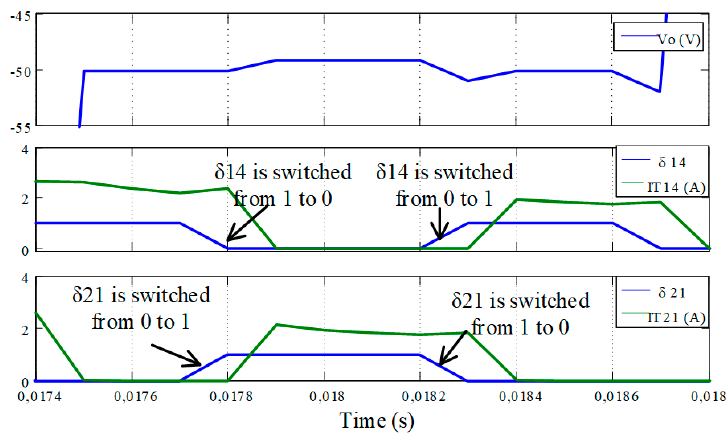
Figure 9. Output voltage V o (t), currents IT21 and IT14, and command of the switches T21 and T14 (Zoom 4).